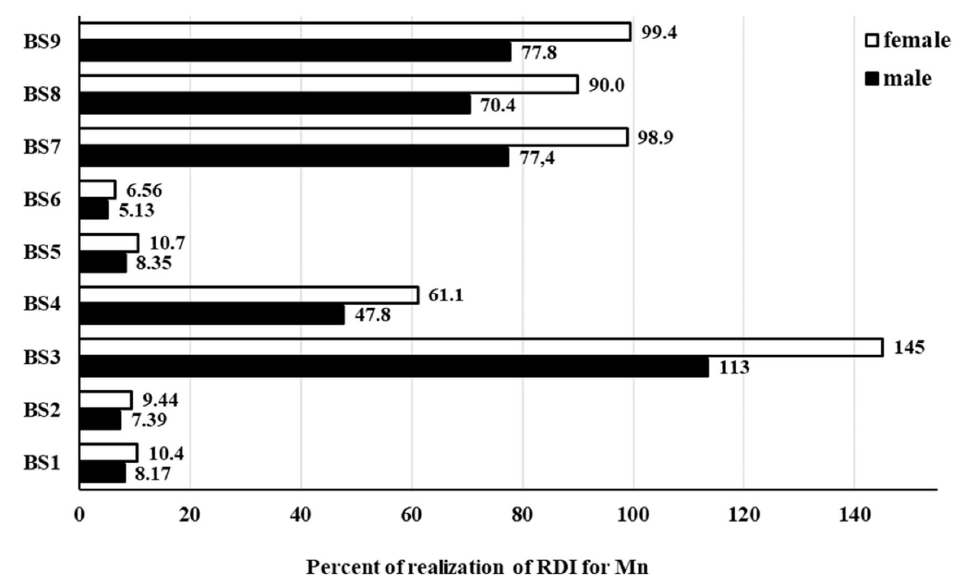
Figure 1. Contribution of birch saps to the Recommended Daily Intakes (RDI) of Mn for male and female related to daily consumption of 1 L of all analyzed birch saps (BS1–BS9).